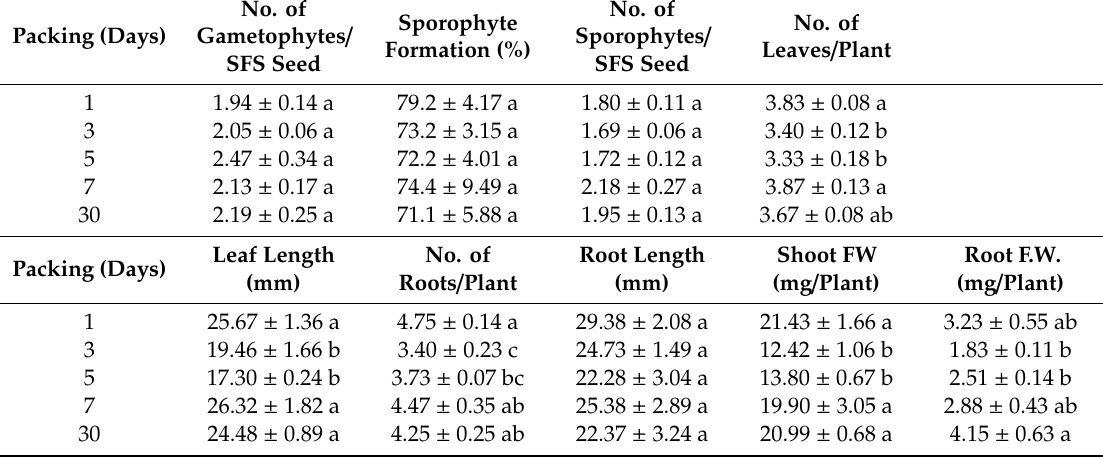
Table 4. E ff ect of short-term storage of SFS (synthetic seeds using fern spores) at 4 ◦ C on sporophyte formation and growth.